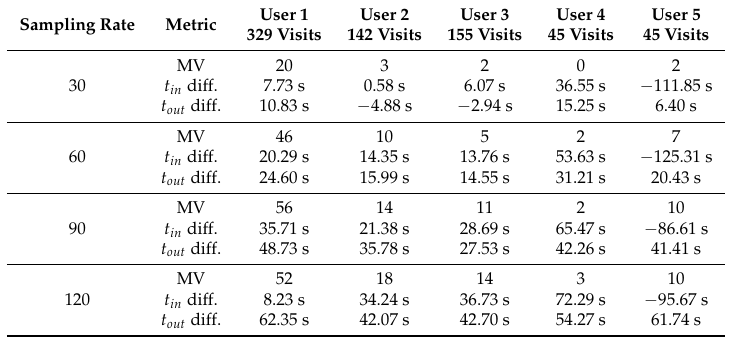
Table 6. Temporal accuracy of the mobility events to construct the cognitive map for different sampling rates. the slower the sampling rates, the larger temporal differences in mobility events. (MV = Accumulated missed visits in trajectories for each user; t in diff. = avg. enter time difference, t out diff. = avg. exit time